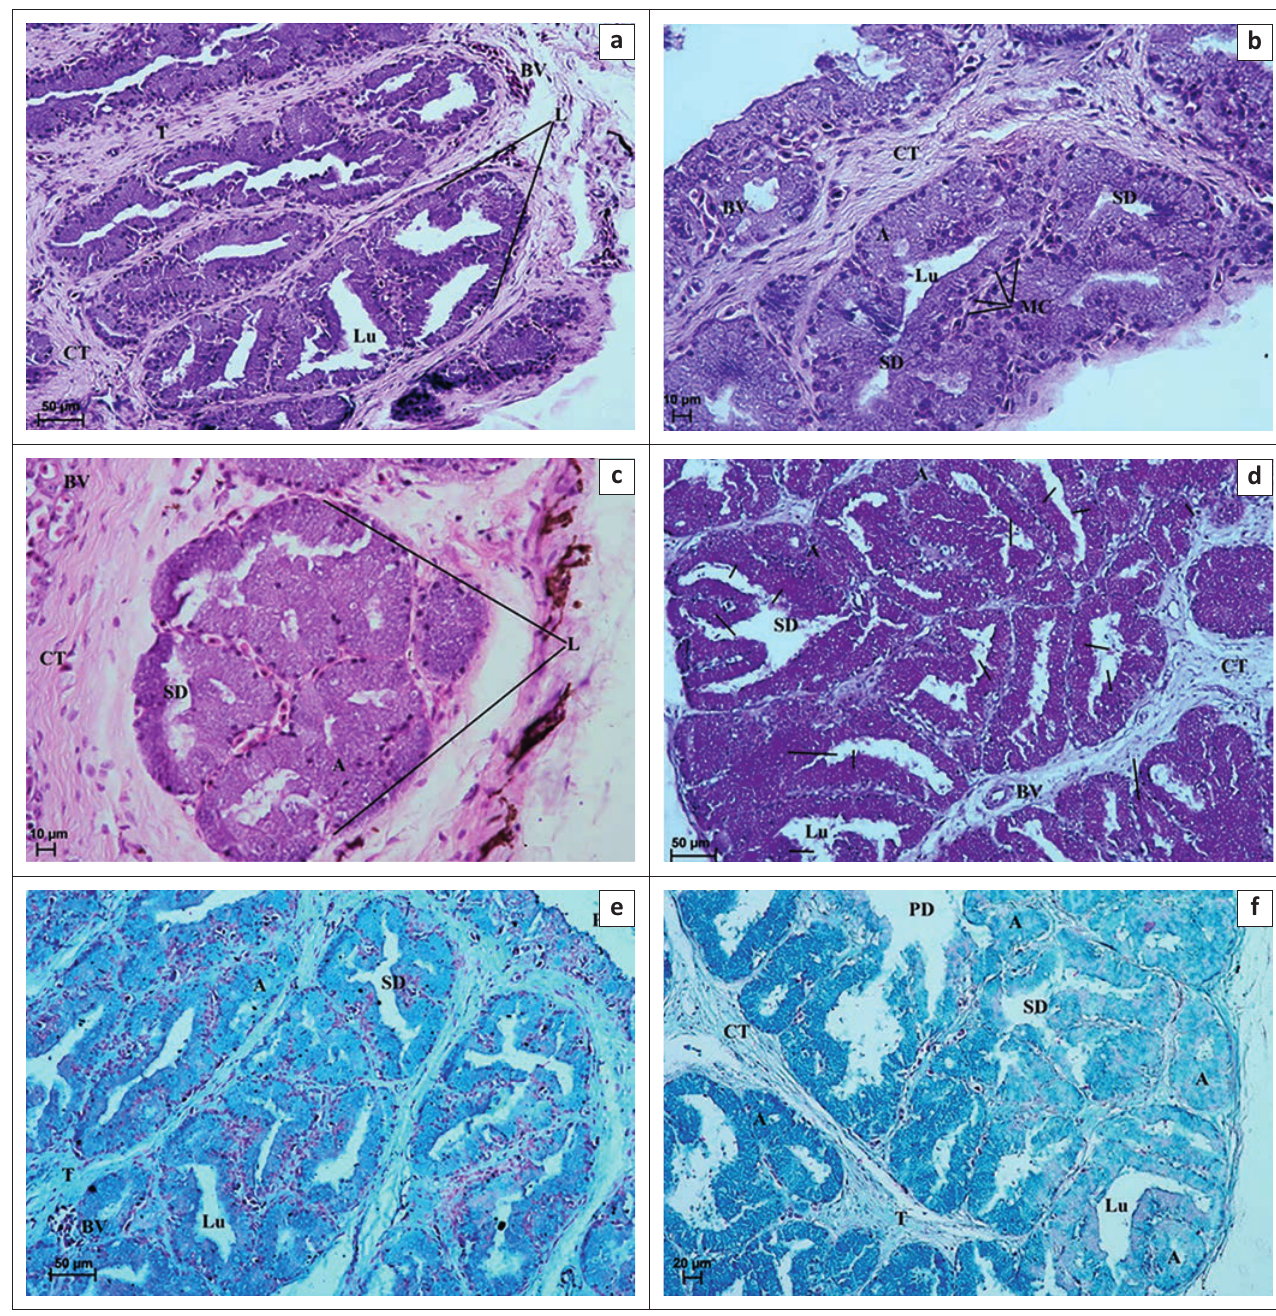
FIGURE 5: Light micrograph of the lacrimal gland in African black ostrich in group 2. (a) 24th hour after hatching, (b) 24th hour after hatching, (c) 72th hour after hatching, (d) 72th hour after hatching, (e) 24th hour after hatching, and (f) 48th hour after